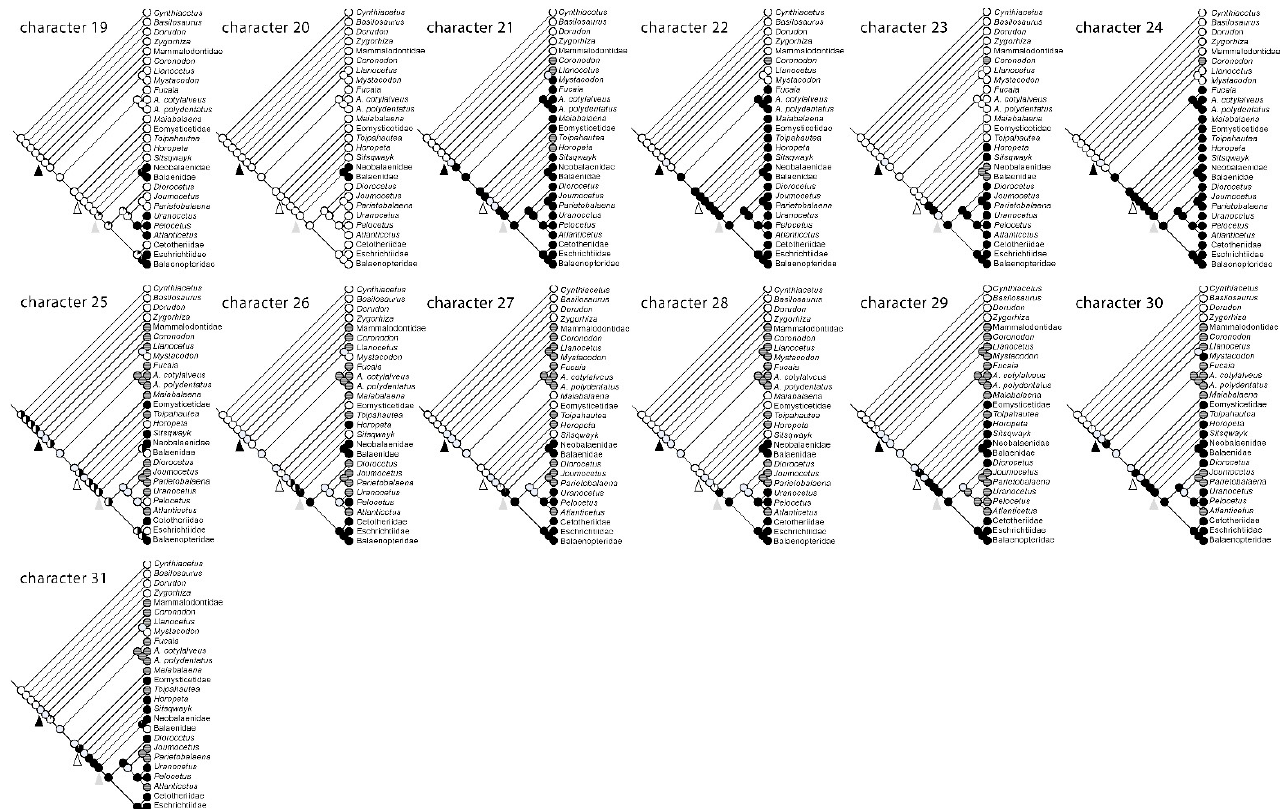
Figure 27. Analysis of the distributions of characters 19–31 of Table 2 in the phylogeny of Figure 1. The black triangle corresponds to the Mysticeti node, the white triangle corresponds to Chaeomysticeti and the gray triangle corresponds to Balaenomorpha.